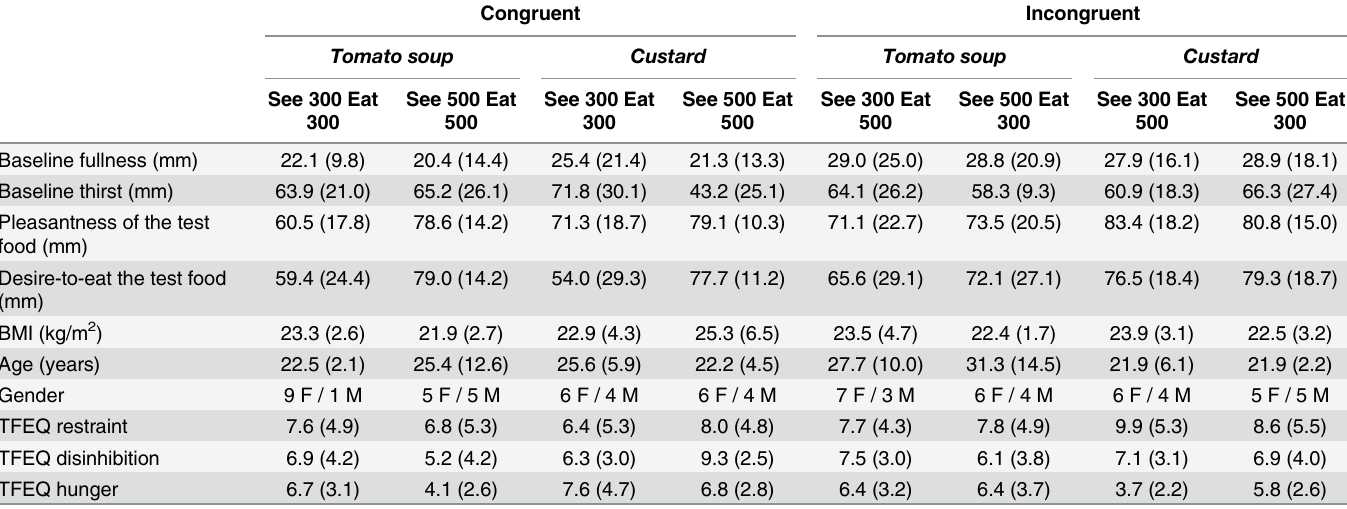
Table 1. Mean ( ± S . D .) scores of baseline fullness (mm), baseline thirst (mm), pleasantness of the test food (mm), desire-to-eat the test food (mm), BMI (kg/m 2 ), age (years), TFEQ restraint, TFEQ disinhibition, and TFEQ hunger, in each condition, separately. The number of males and females in each condition are also